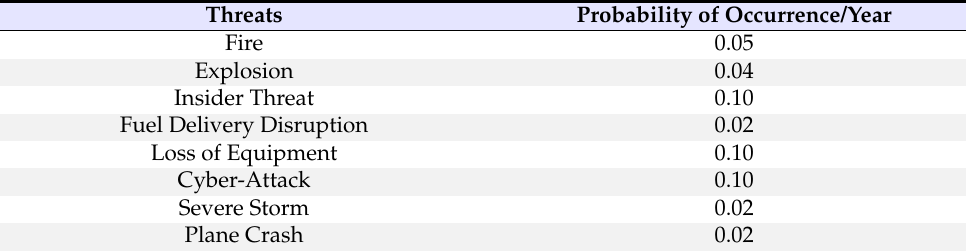
Table 5. Probability of Occurrence for Postulated Threats. The threats and probabilities are derived from a number of sources including natural disasters (e.g., fire, flood, fire, seismic, high winds, tornado, hurricane, etc.) and human-caused events [52,53]. It is important to note the limitations on historical data due to climate change. Increasing climate changed has caused considerable changes in weather patterns and poses risk to military